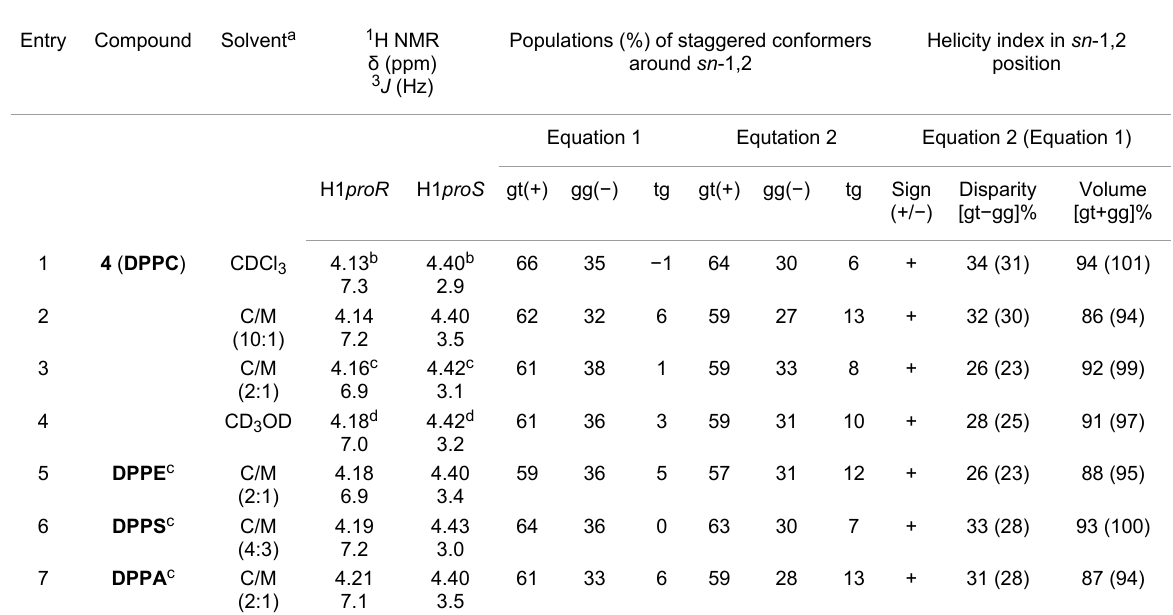
Table 3: 1 H NMR data of 1,2-dipalmitoyl- sn -glycero-3-phospholipids and their helical conformational properties in solution